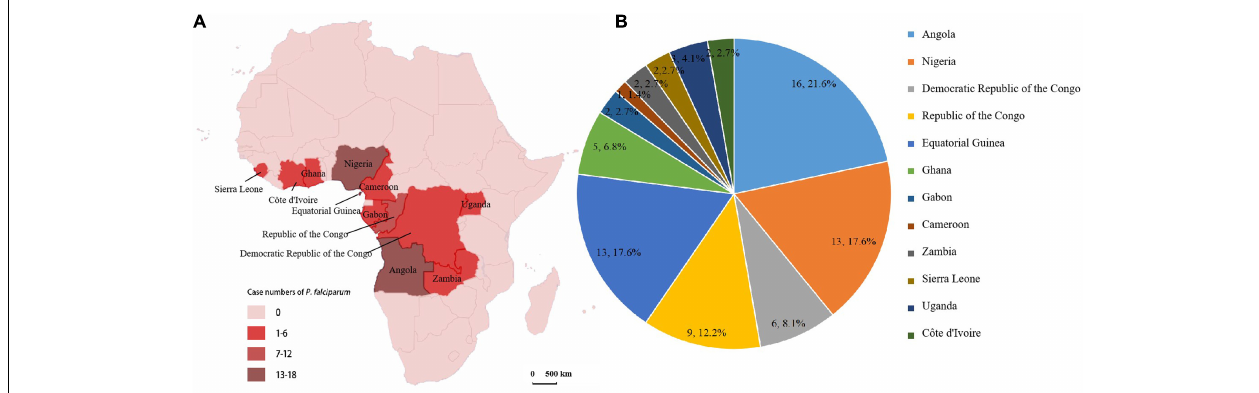
FIGURE 1 | Origins of malaria cases were imported from 12 countries of sub-Saharan Africa to the Jiangsu Province of China. (A) A map of Africa showing the countries of origin of P. falciparum isolates. (B) The total number of genotyped samples per region and percentage of samples. TABLE 1 | Origin of imported Plasmodium falciparum in 2015–2019. Country